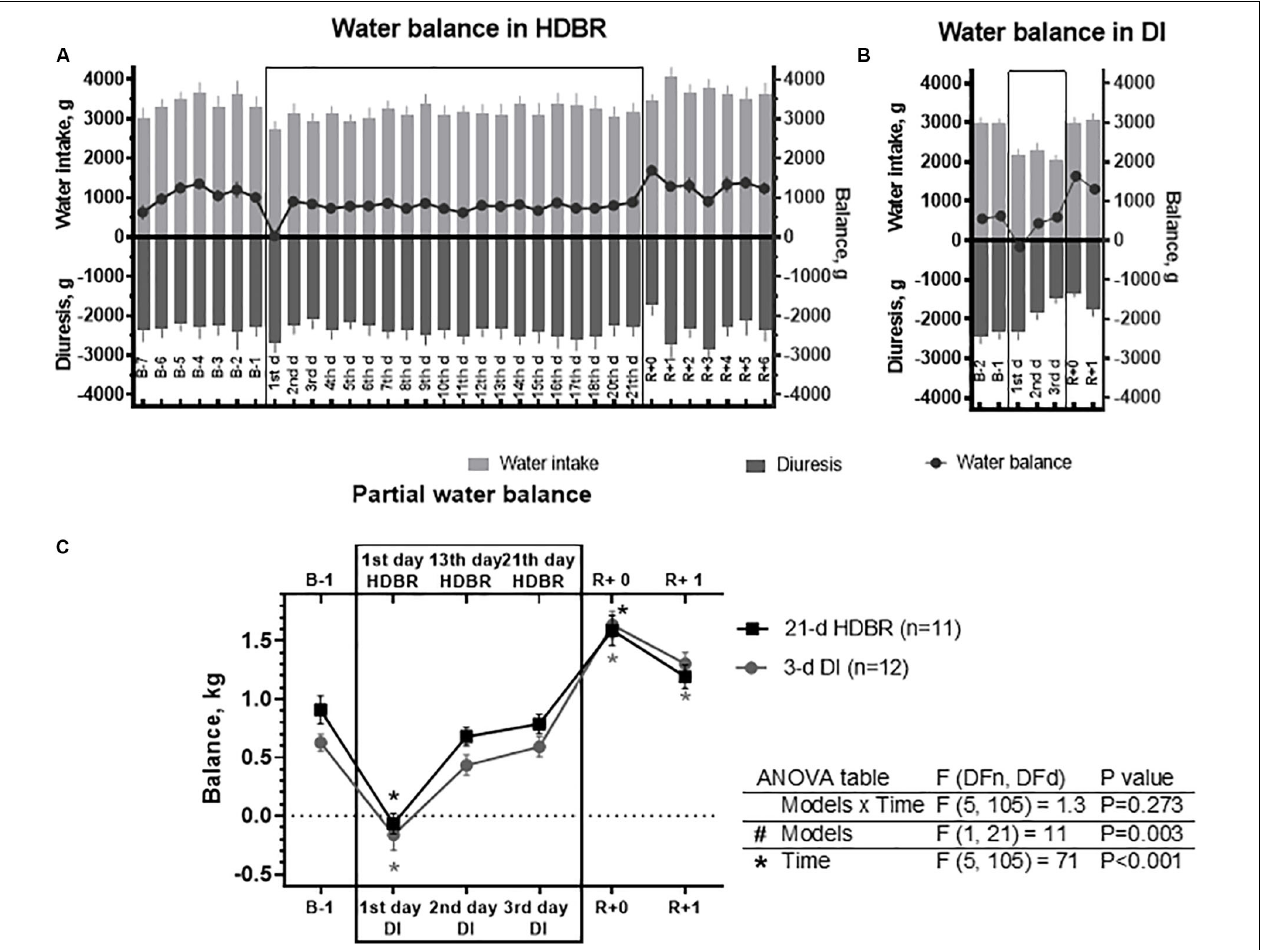
FIGURE 2 | Changes in partial water balance in the 21-day head-down bed rest (HDBR) (A) , 3-day dry immersion (DI) (B) , and their comparison between both groups (C) . Data are the mean ± SEM. * p < 0.05 vs. before exposure.